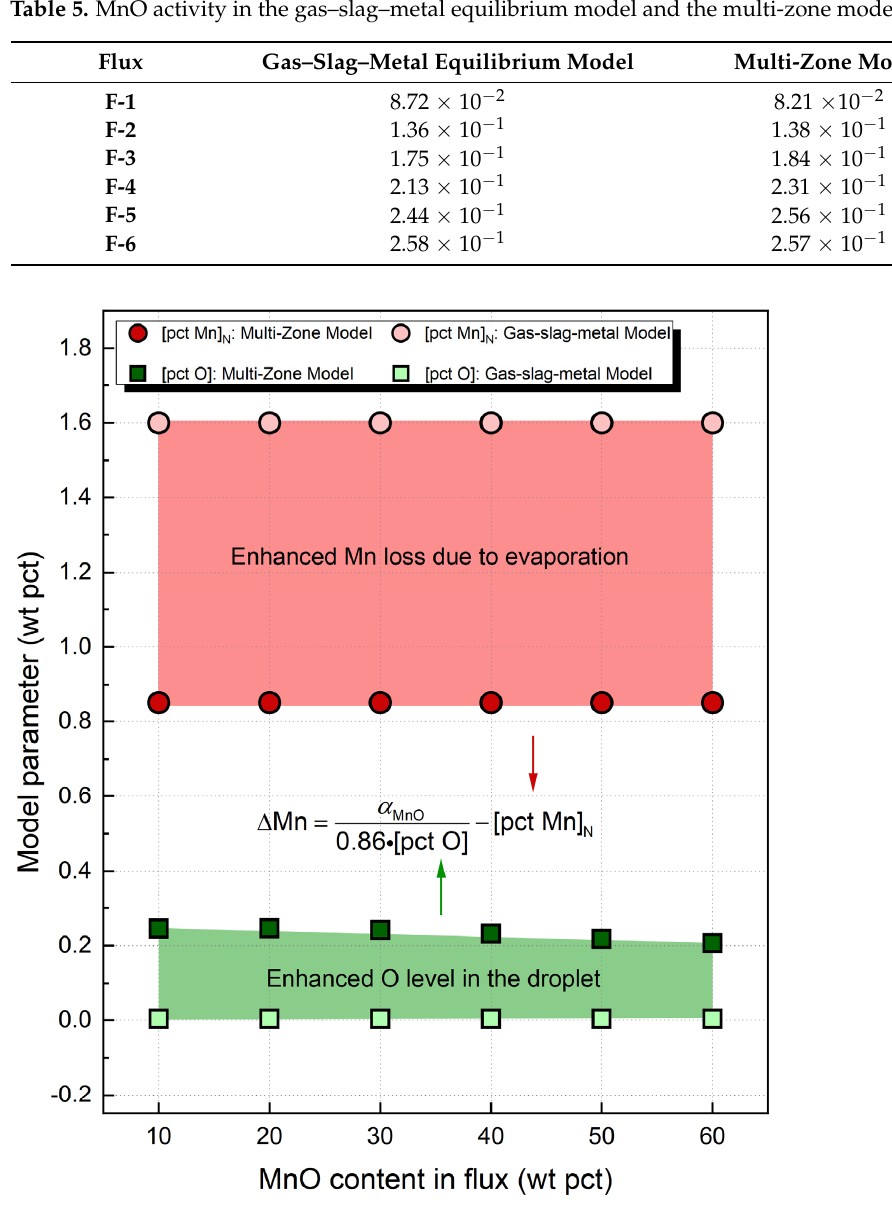
Figure 5. Model parameter pertinent to the level of ∆